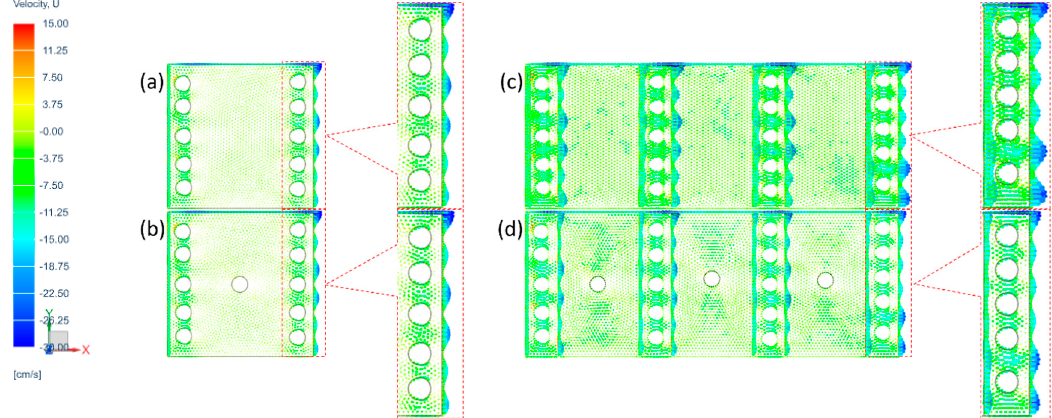
Figure 10. Velocity profile of ( a ) 2L- air gap, ( b ) 2L-S gap, (c ) 4L-air gap, ( d ) 4L-S gap. The inlet velocity was set as 15 cm / s, and the outlet velocity was simulated.